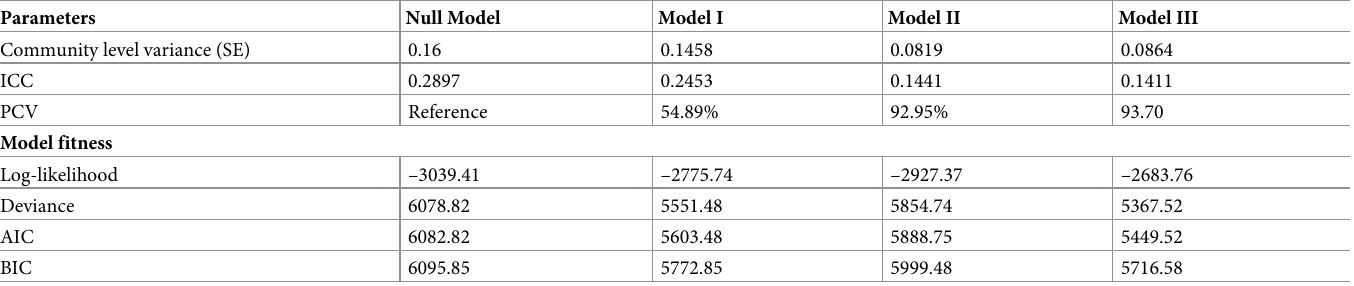
Table 4. Random effect analysis and model fitness for assessing factors associated with modern contraceptive utilization among married women in Ethiopia, EMDHS